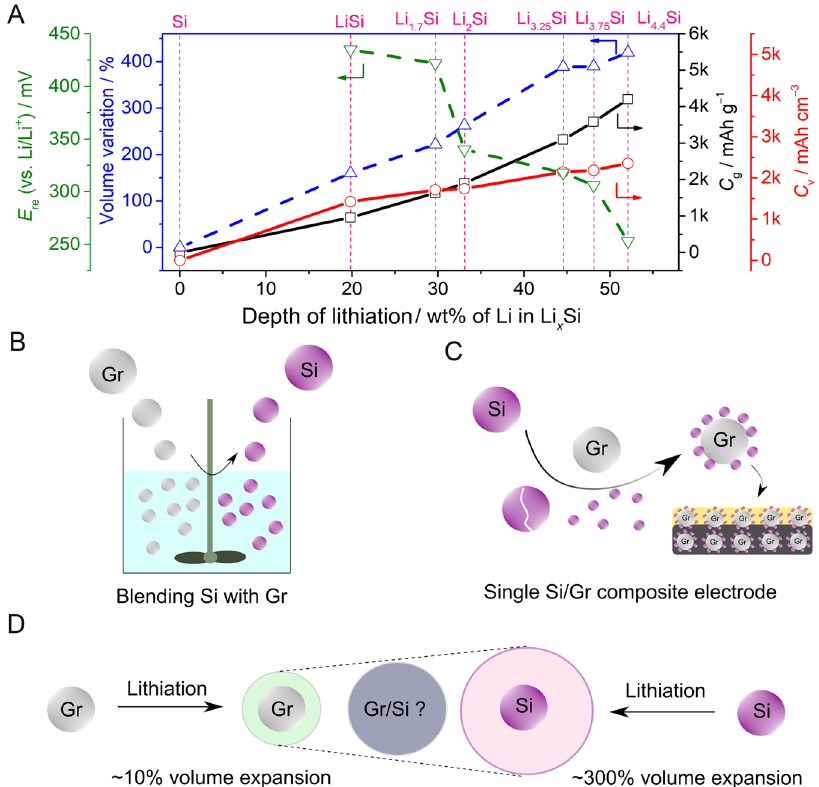
Fig. 2 Negative electrode chemistry for pure silicon and Si-based materials. A Theoretical capacity [speci fi c ( C g ) and volumetric capacity ( C v )], volume variation upon (de)alloying, and reaction potential ( E re ) for various lithiated Si electrodes. B Mechanical blending of Si with Gr during the electrode fabrication process. C Building a single Si/Gr composite electrode. D Volume expansion in Si-Gr blend/composite